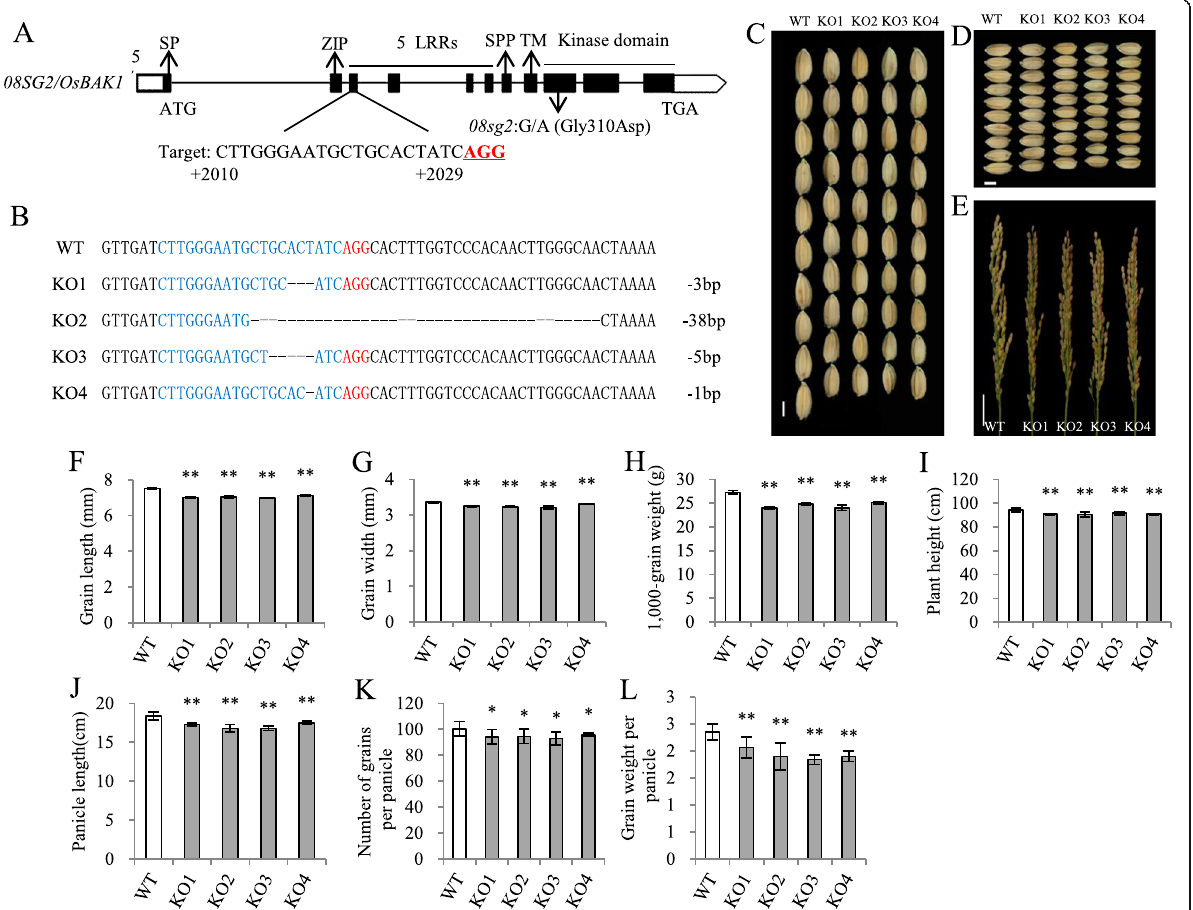
Fig. 3 Generation of loss of function mutants of OsBAK1 and comparisons of their phenotypes. a Schematic diagram of the target sites in the OsBAK1 . The UTRs, exons and introns are indicated by blank rectangles, black rectangles and black lines, respectively. The targeted sites are labeled in black uppercase letters. and the protospacer adjacent motif (PAM) sequences are highlighted in red and underlined. The numbers labeled under the target sequences indicate the distance away from the translation start site (ATG, from 5 ’ to 3 ’ ). SP, signal peptide. ZIP, leucine zipper. LRRs, leucine-rich repeats. SPP, pro-rich domain containing the Ser-Pro-Pro (SPP) motif. TM, transmembrane domain. The start codon (ATG) and the stop codon (TGA) are indicated. The 08sg2 mutation in the OsBAK1 was shown. b Sequence alignment of the mutants within the OsBAK1 target in the T 1 plants. The wild-type (WT) sequence is depicted at the top with the target sequence in blue and the PAM sequence in red. The deleted sequences are shown by black hyphens, and the number of the deletions are showed on the right. c , d Comparisons of the grain length and grain width between WT and knock out mutants. Scale bar, 3 mm. e The panicle morphology of WT and knock-out mutants. Scale bar, 3 cm. f Grain length. g Grain width. h 1,000-grain weight. i Plant height. j Panicle length. k Number of grains per panicle. l Grain weight per panicle. All phenotypic data in F – L were measured from plants grown in paddies under normal cultivation conditions with three-time repeats. Data are given as means ± SD. Student ’ s t-test was used to generate the P values; *, ** indicate P < 0.05, P < 0.01, respectively